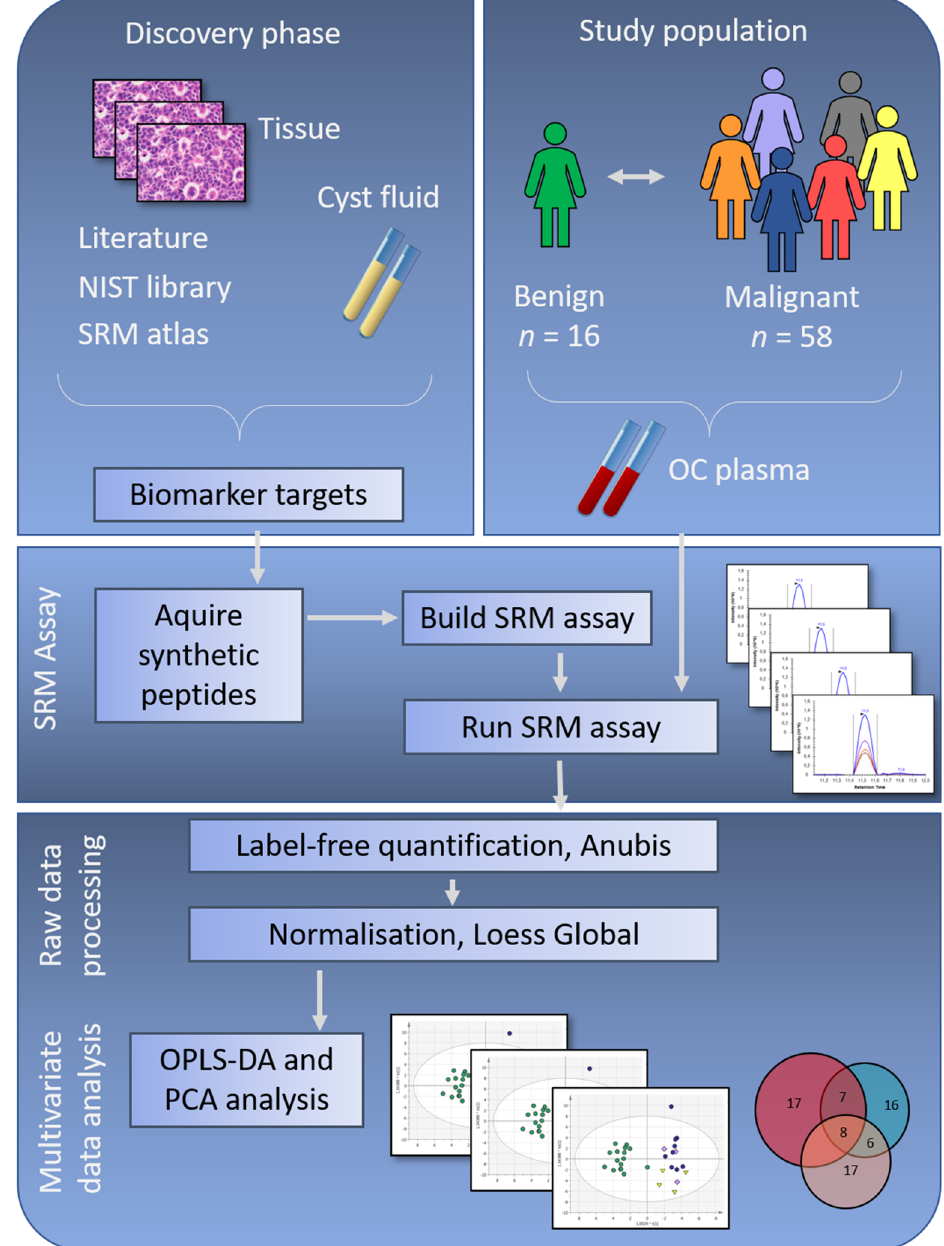
Figure 1. Study workflow showing the discovery phase with protein selection based on ovarian cancer (OC) tissue and cyst fluid, together with selected literature references and relevant data deposited in repositories. Meanwhile, the study population was selected, with inclusion of samples from benign, early-stage and late-stage OC. To verify if the potential biomarker targets identified in the discovery phase were possible to identify in patient plasma samples, synthetic peptides corresponding to the biomarker targets were ordered, and a selected reaction monitoring (SRM) assay was built. Peptides with stable identification in a group of pooled plasma samples were included in the final SRM assay, which was run on plasma samples from the complete study population. In the final step of this study, multivariate analyses were used to retrieve information on OC subgroup differences. NIST = National Institute of Standards & Technology, n = number of samples, OPLS-DA = Orthogonal Projection to Latent Structures - Discriminant Analysis, PCA = Principal Component Analysis